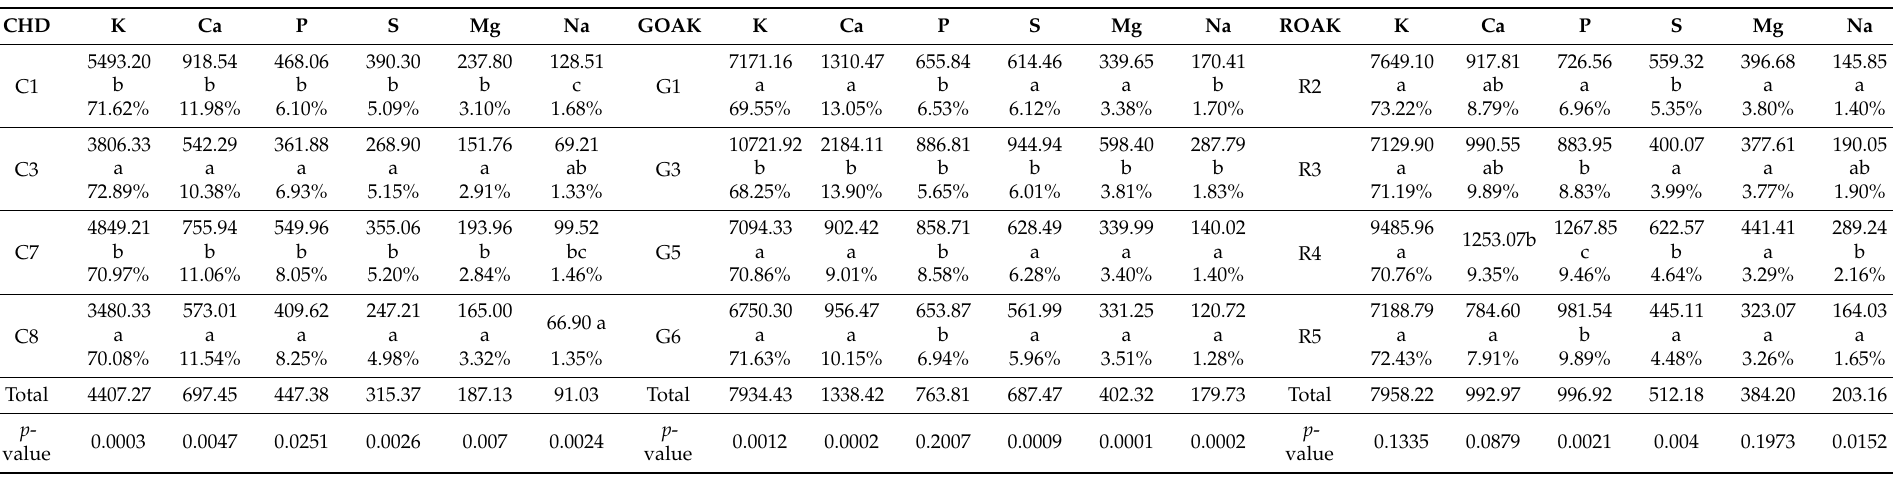
Table 5. Individual analysis of each macronutrient studied in this trial (ppm) at the genotype level for each cultivar. Percentages refer to the proportion of each nutrient in each type of genotype. Data are means of 9 replicates with different letters for each column indicating significant differences ( p -value < 0.01) as determined by LSD multiple comparisons test in the four genotypes analyzed per cultivar ( p